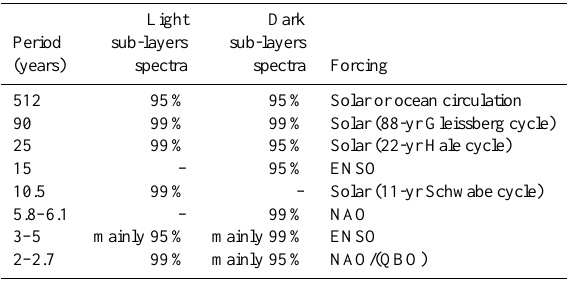
Table 1. Summary of significant spectral peaks of light and dark sub-layer time series of the Dethlingen varves and their possible forcing